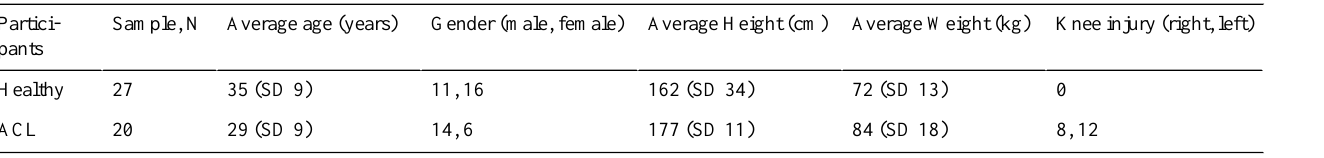
Table 1. Participant